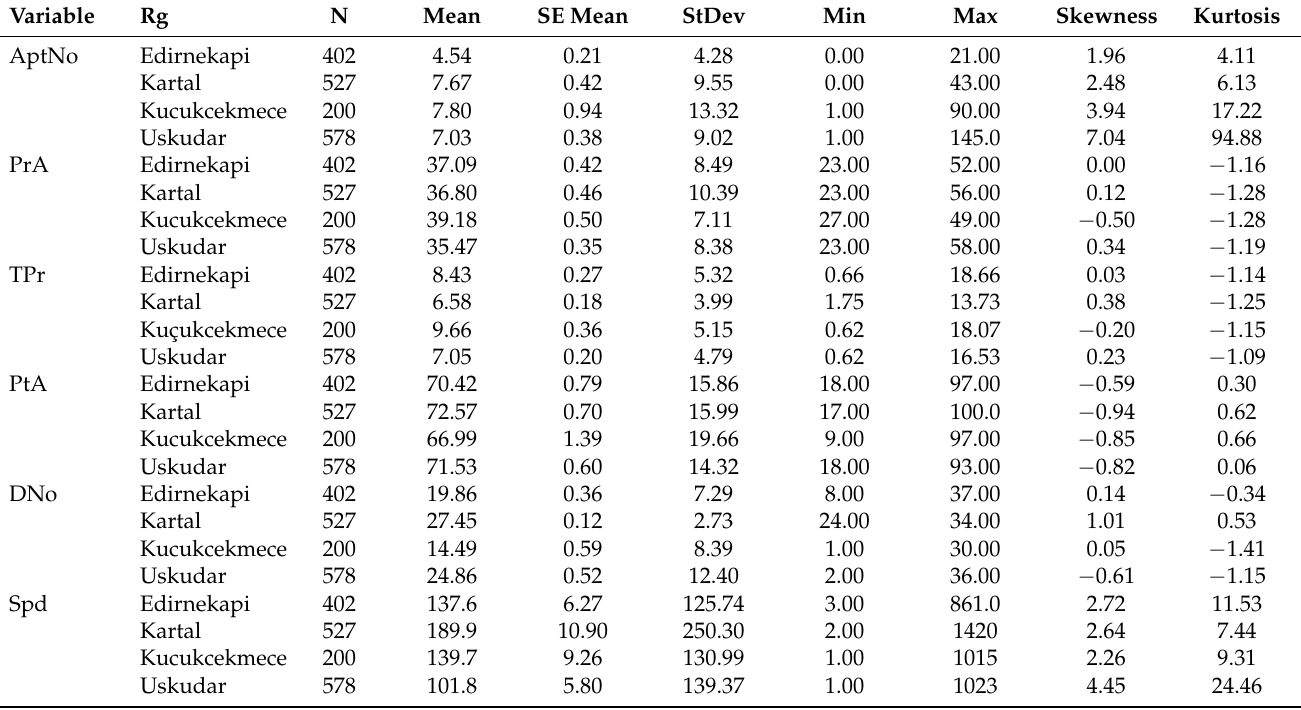
Table 2. The values of descriptive statistics of independent and dependent variables based on the region